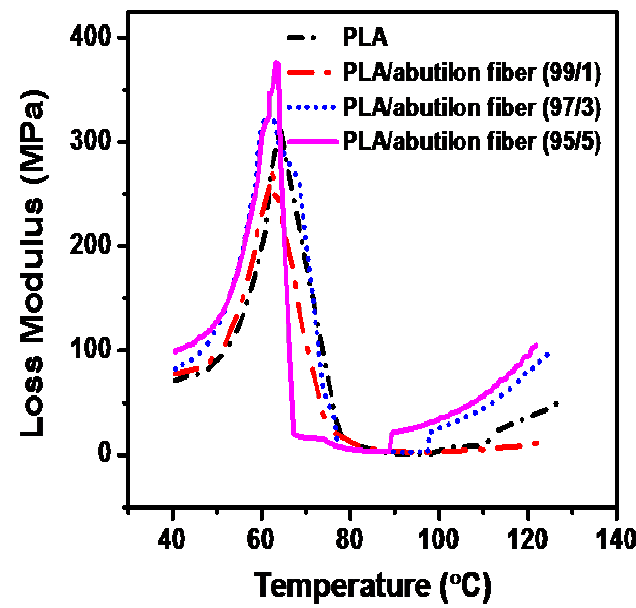
Figure 6. The storage modulus of the composite samples (PLA/abutilon fiber).